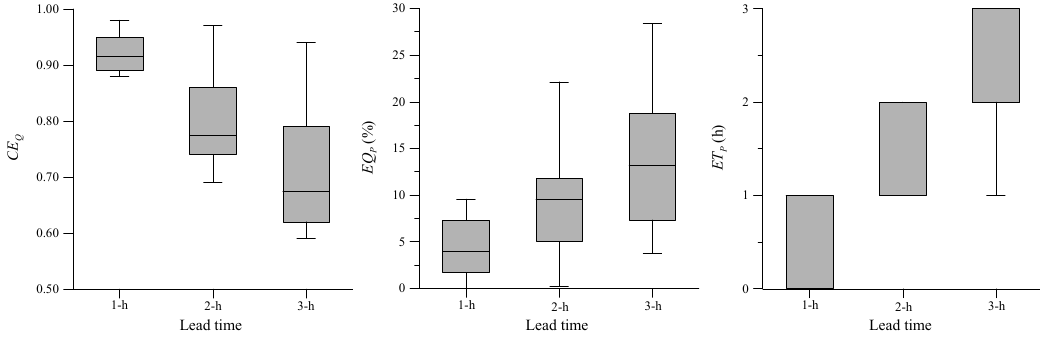
Figure 10. Results of evaluated criteria for flow forecasting using forecast rainfall and flow updating technique.